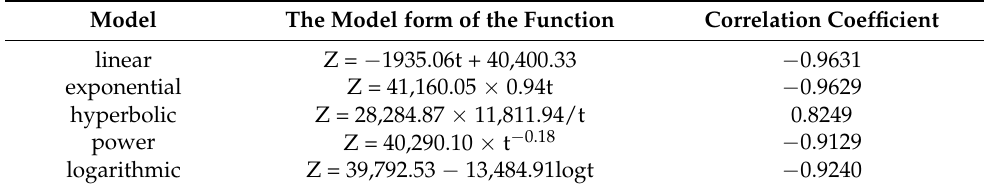
Table 8. A summary of the regression analysis results for the domestic coal sales (“Export